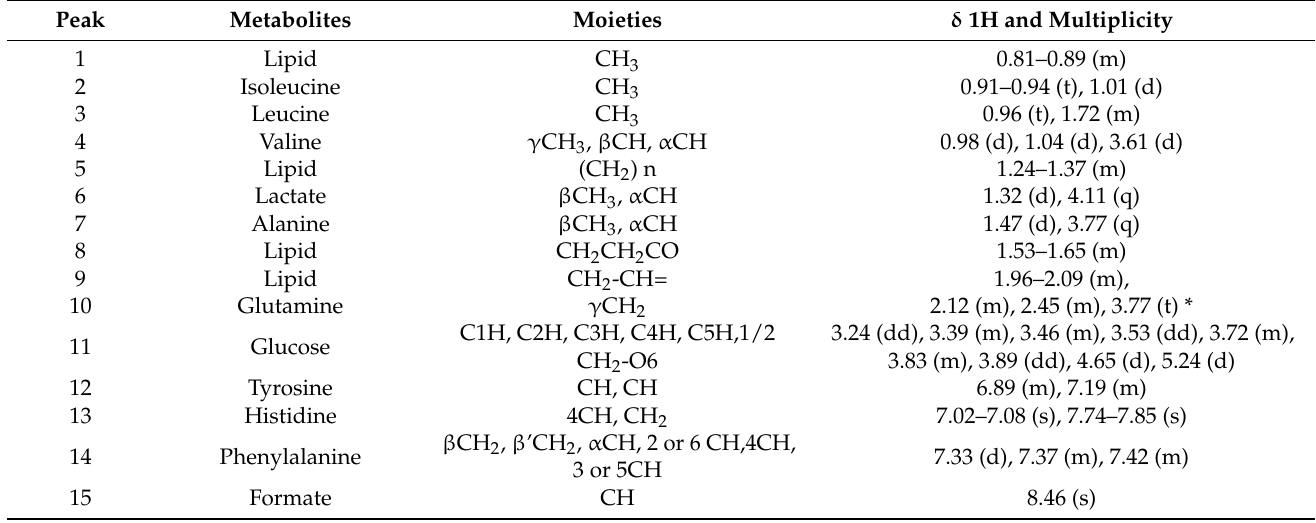
Table A3. 1 H-NMR chemical shift assignments for the metabolites found between thrombosis vs. control groups. s, singlet; d, doublet; t, triplet; q, quartet; m, multiplet; dd, doublet of doublets. * Overlapping